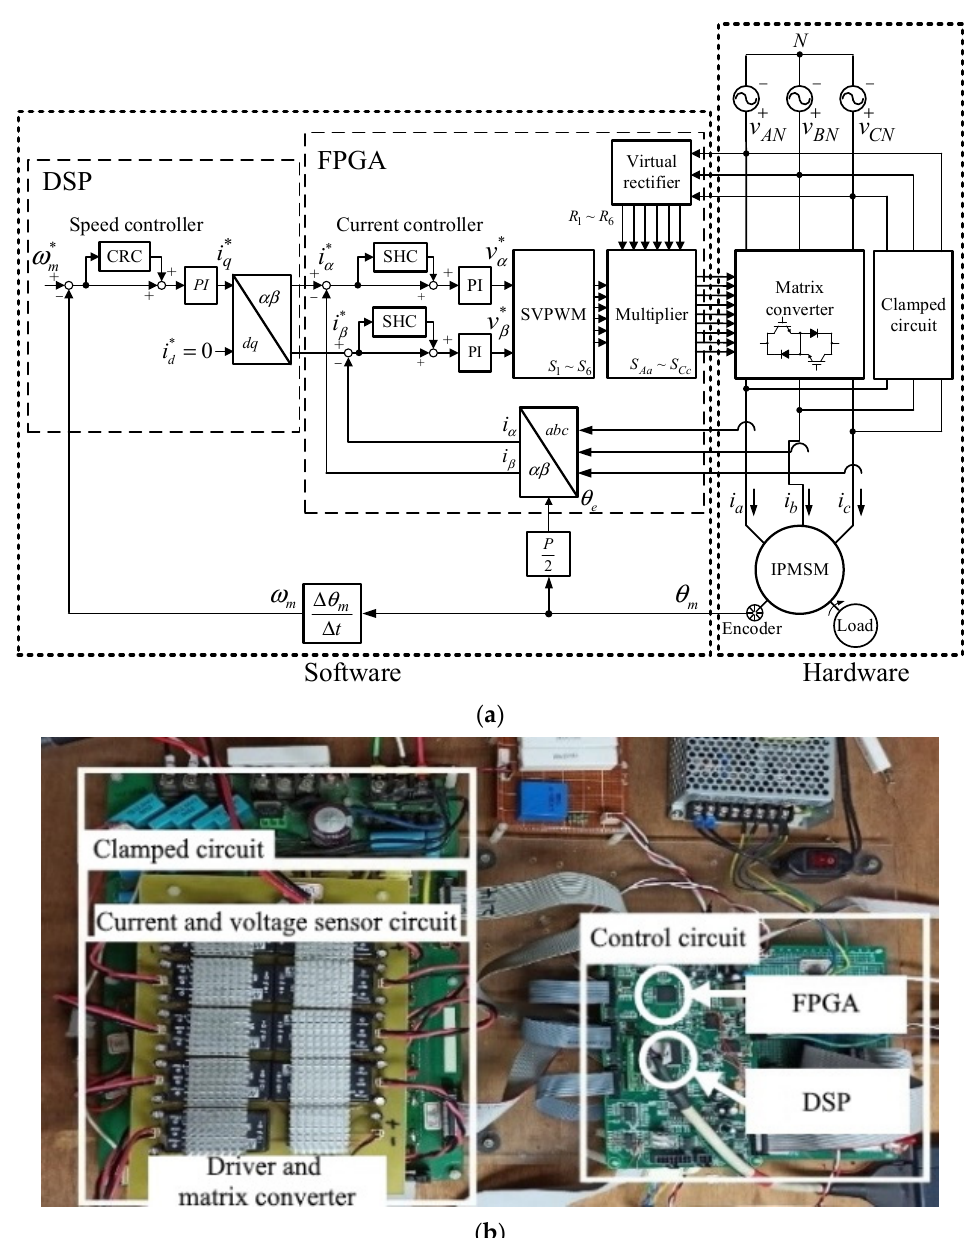
Figure 10. The implemented system: ( a ) block diagram; ( b ) hardware